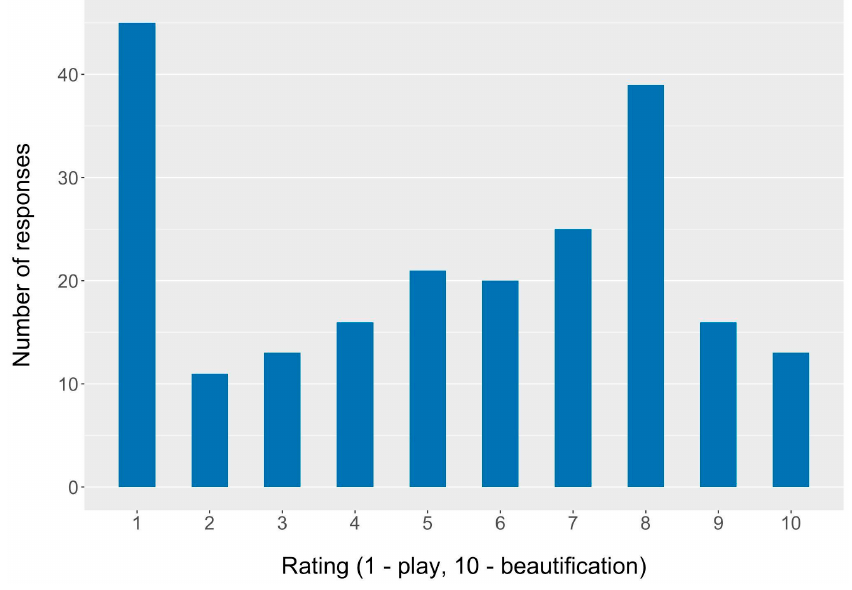
Figure 3. CMBP-use motivation scale (play–beautification rating) histogram ( n = 219). Because differences in cosmetic product use by race and ethnicity have been previ- CMBP usage behaviors by parent/guardian ethnicity (Table 3). Significant differences be- tween the types of products used, exposure measures, and motivations for use were found between Hispanic/Latinx respondents and non-Hispanic respondents. A significantly greater proportion of children of Hispanic/Latinx parents/guardians used lip, fragrance, and hair products ( p < 0.01 for all). Children of Hispanic/Latinx parents/guardians were reported to use CMBPs more frequently ( p = 0.047) but for shorter durations ( p < 0.001) than children of non-Hispanic parents/guardians. Hispanic/Latinx parents/guardians re- ported significantly lower child ingestion rates of CMBPs ( p < 0.001) and reported reading ingredients of CMBP less frequently before purchasing ( p = 0.01) than non-Hispanic par- ents/guardians. For the settings of product use, significantly more children of His- panic/Latinx parents/guardians used CMBPs in solo play and day-to-day activities, and significantly less used them in performances than children of non-Hispanic/Latinx par-